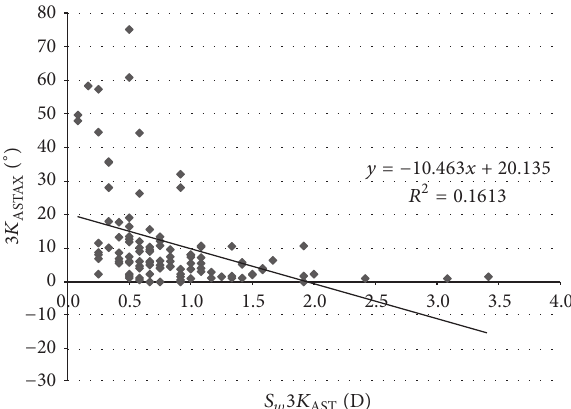
Figure 3: Scatterplot showing the relationship among the mean magnitude of corneal astigmatism in the 3mm central zone ( 3𝐾 AST ) and the within-subject standard deviation ( 𝑆 𝑤 ) associated with the axis of such corneal astigmatism ( 3𝐾 ASTAX ). The adjusting line of data obtained by means of the least-squares fit is displayed.